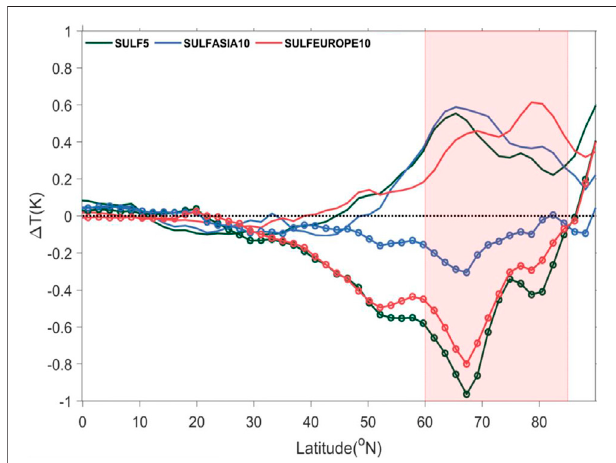
FIGURE 3 | Zonal mean surface temperature anomalies for summer (solid line with markers) and winter (solid lines) for SULF5 (green line), SULFASIA10 (blue line) and SULFEUROPE10 (red line) experiments. The shading shows the zone of maximum effect.